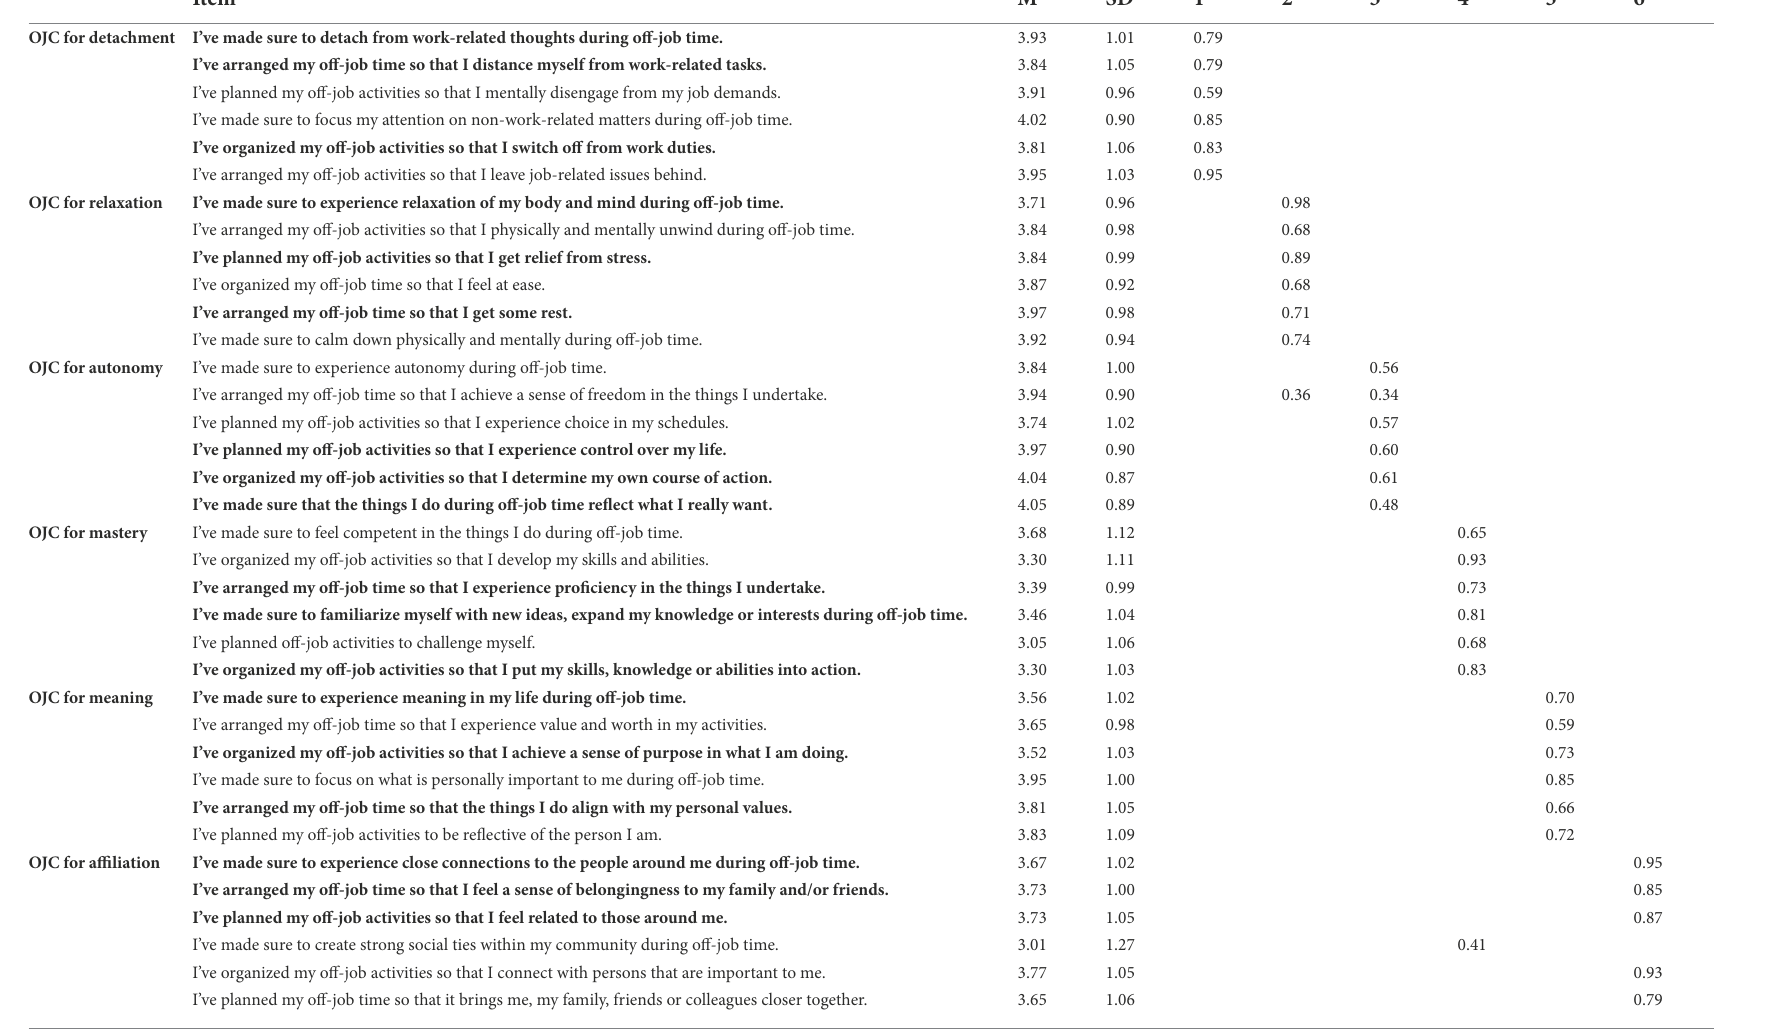
TABLE 1 EFA Factor Structure in Study 1 with the 36-item Version of the NOCS.